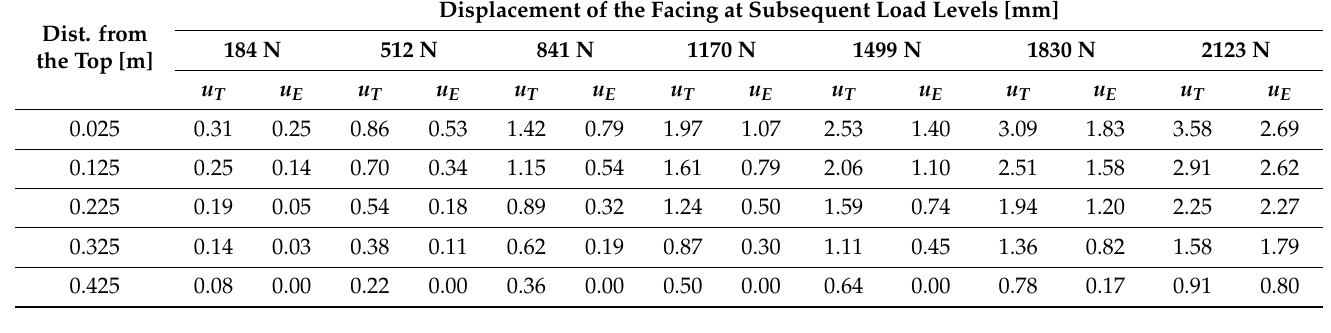
Table 5. Calculated ( u T ) and experimental ( u E ) displacement of the facing at subsequent load levels.